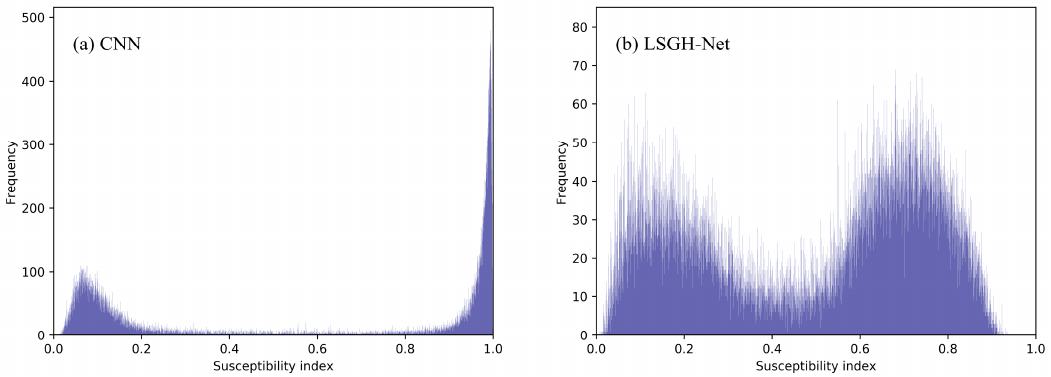
Figure 10. Frequency histograms of the landslide susceptibility index.